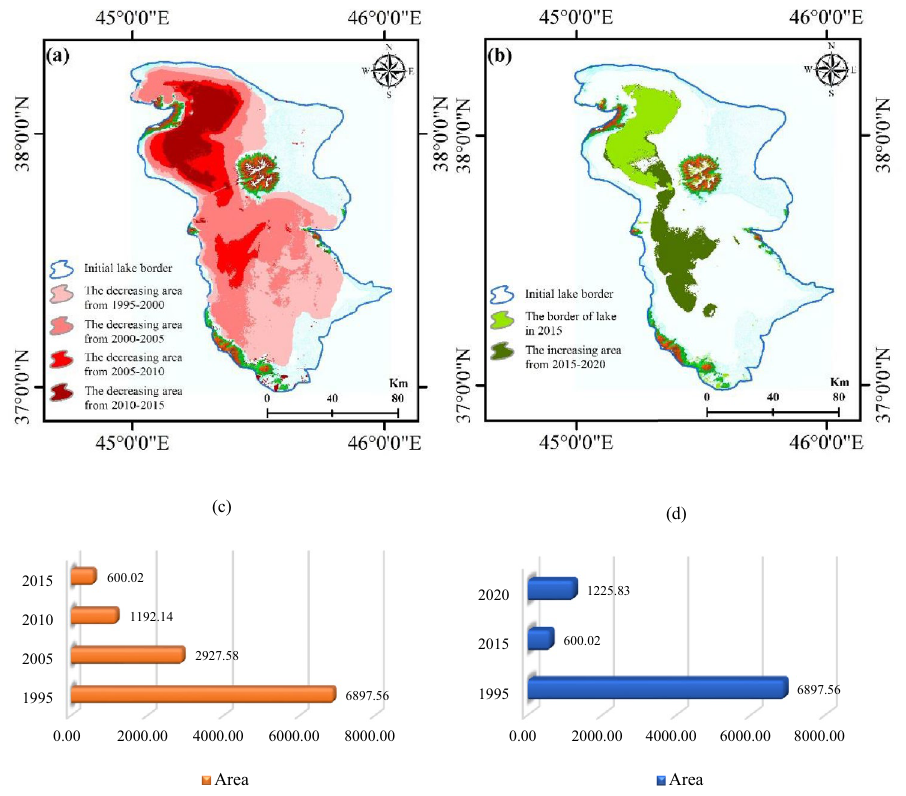
Figure 5. ( a , c ) Decreasing (km 2 ), and ( b , d ) increasing water levels (km 2 ) from 1995 to 2020, generated in